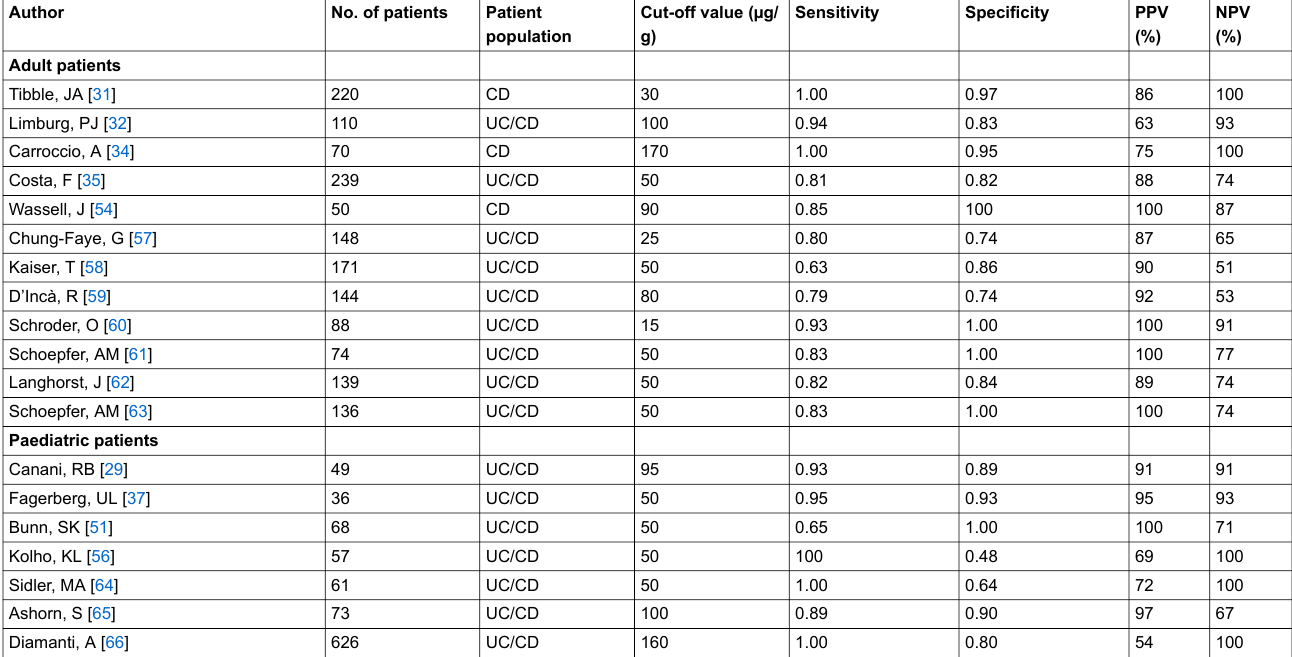
Table 2: Diagnostic precision of studies investigating the use of faecal calprotectin in distinguishing inflammatory bowel disease (IBD) from non-IBD.